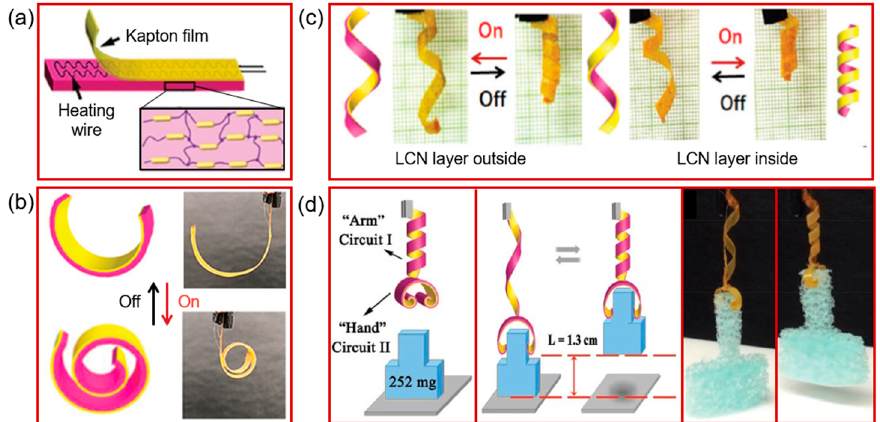
Figure 12. Electro-thermal liquid crystalline network (ELCN) actuators. ( a ) The integrated ELCN actuator; ( b ) the bending states of the ELCN actuator driven by the external voltage; ( c ) illustration of an ELCN actuator strip programmed to have a helical LCN shape with either an outside layer or inside layer, and the corresponding reversible actuation when the power is off and on. ( d ) Photographs of the self-locking gripper made with the ELCN actuator, which can grip and lift an object by operating the programmable hand and arm by using two electric circuits (Reprinted (adapted) with permission [141] . Copyright (2019) John Wiley and Sons).